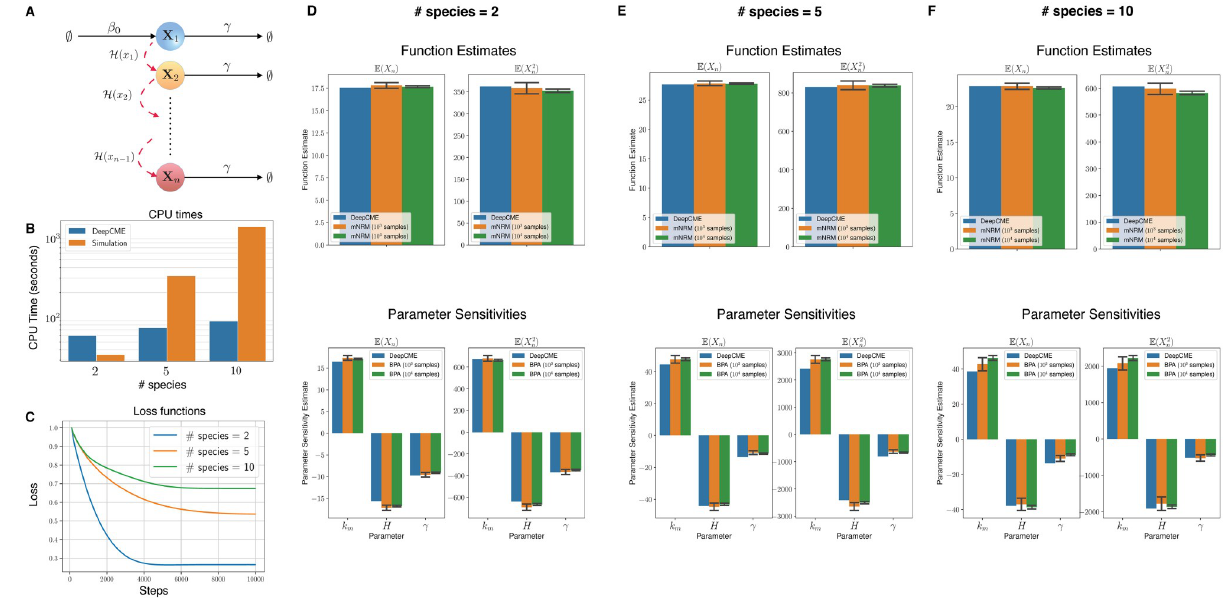
Fig 5. Nonlinear signalling cascade. (A) Depicts the network with n species and 2 n reactions. The reactions shown with red dashed-arrow have propensities given by a nonlinear activating Hill function (32). Other reactions have mass-action kinetics. (B) The CPU times are shown for DeepCME for different values of n (denoted as # species), and for comparison the time needed by simulation based methods (mNRM for function estimates and BPA for parameter sensitivities) with 1000 trajectories is also indicated. (C) Plots the validation loss function w.r.t. training steps for various n values. Panels (D-F) show estimates for the function values ( E ð X ð T ÞÞ and E ð X 2 ð T ÞÞ ) at T = 1 and the parameter sensitivities (only the significant sensitivities n n are shown). The estimates with simulation based methods are shown as 95% confidence